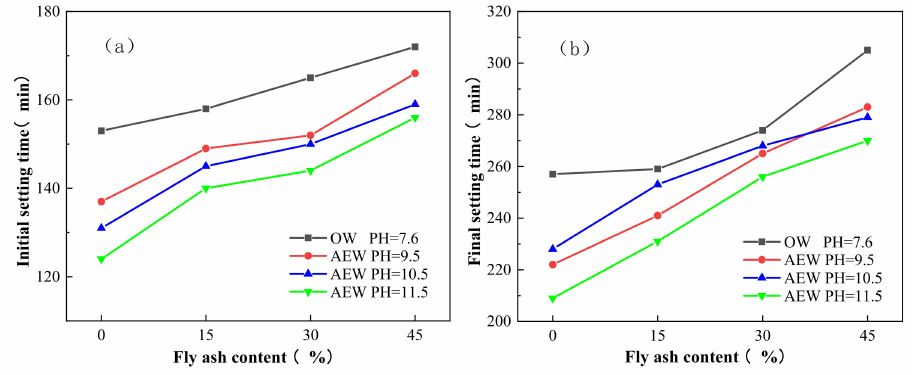
Figure 15. Initial and final setting times of OW and AEW with different pH for different FA replace- ments: ( a ) Initial setting time; ( b ) Final setting time.